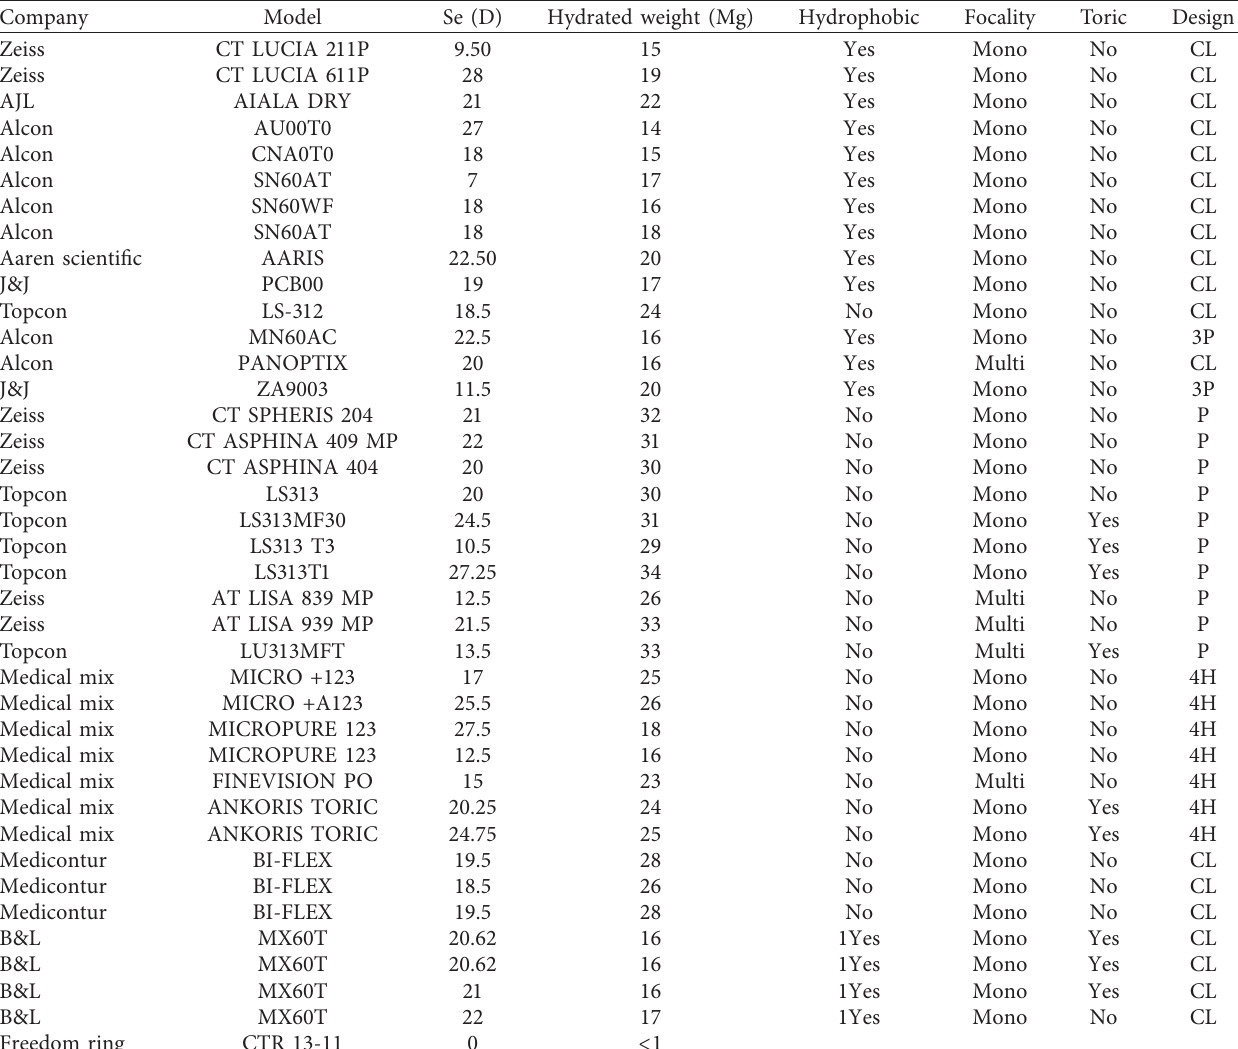
Table 1: Weights and characteristics of all IOLs included.